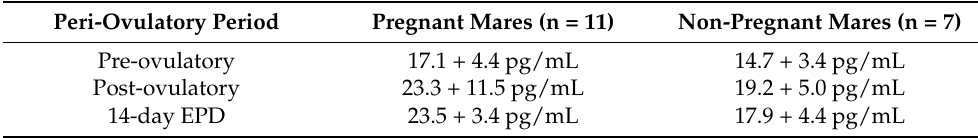
Table 1. Mean ± standard deviation for immunoreactive plasma adrenocorticotropic hormone (ACTH) concentrations associated with early pregnancy and peri-ovulatory period. (EPD: early pregnancy